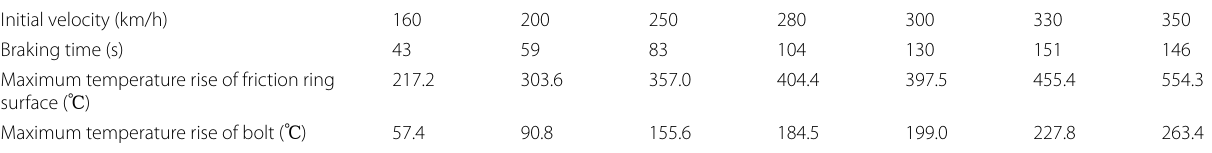
Table 3 Maximum temperature rise of brake disc friction ring and bolt in emergency braking with different initial speeds Initial velocity (km/h) Braking time (s) Maximum temperature rise of friction ring surface ( ℃ ) Maximum temperature rise of bolt ( ℃